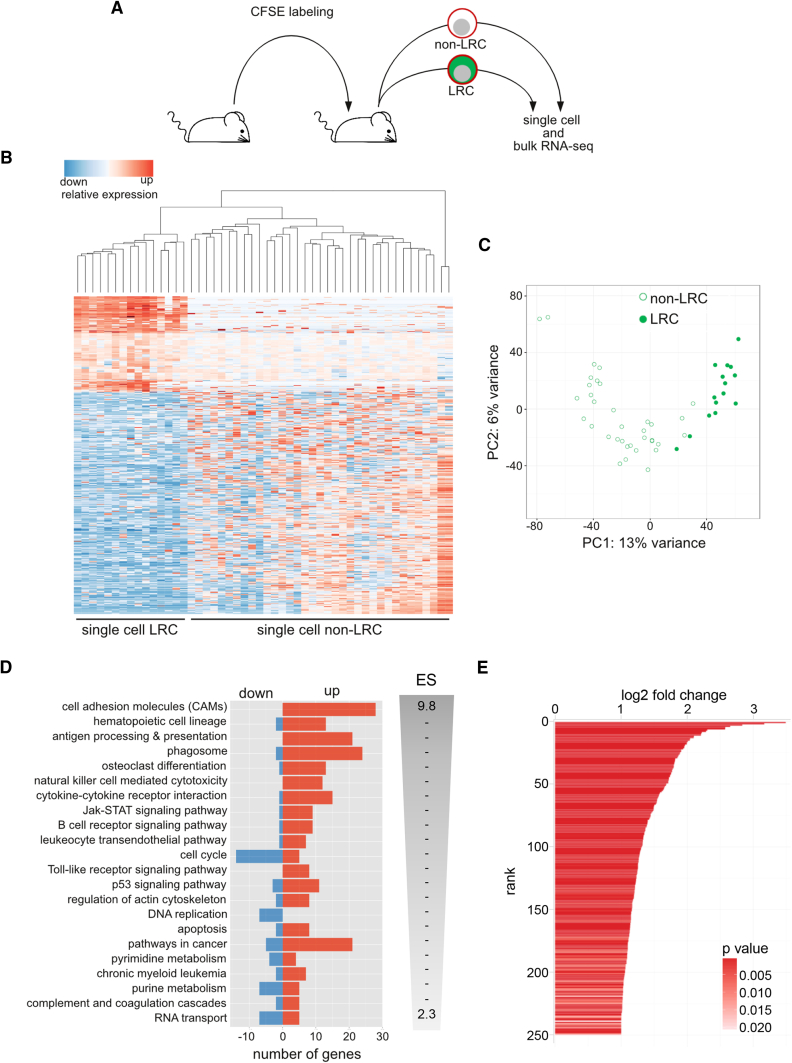
Expression Profile of LRC Shows Distinct Changes to Non-LRC(A) Fifteen days after transplantation, ALL-265 LRC or non-LRC were isolated and single-cell mRNA-seq was performed in 15 LRC and 35 non-LRC.(B) Hierarchical clustering and gene expression heatmap across the 500 most differentially expressed genes (false discovery rate [FDR] <0.01) in 15 LRC and 35 non-LRC single cells. Values are plotted relative to the average of non-LRC.(C) Principal component analysis of the 500 most variable genes in all 50 single cells.(D) Significantly enriched KEGG pathways (FDR <0.05) as determined by fixed network enrichment analysis (FNEA); bars show the number of significantly up- or downregulated genes in the corresponding pathway and are ordered according to the enrichment score (ES).(E) LRC signature genes (FDR < 0.05 and log2 fold-change >1) were derived from integrated bulk and single-cell RNA-seq analysis from six animals carrying either ALL-265 or ALL-199 and are shown ranked by fold-change and colored by significance.See also Figure S5, Tables S4, S5, and S6.